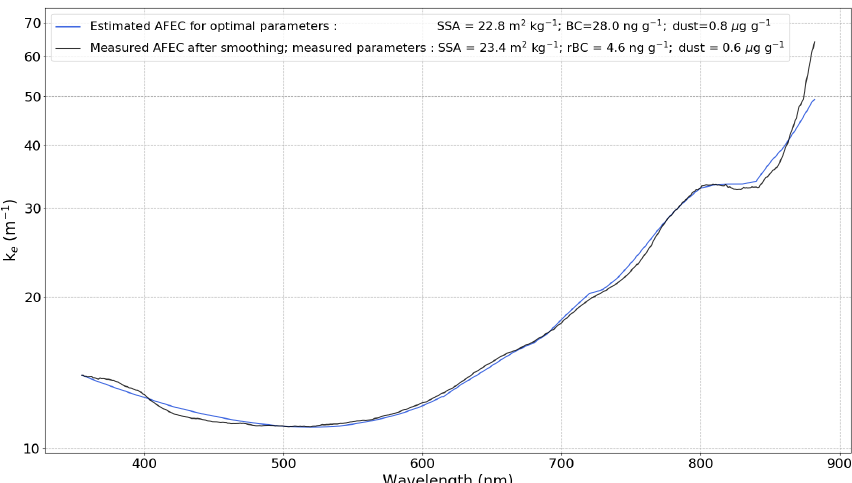
Figure 5. AFEC as a function of wavelength for the ZOIs between 11 and 14cm on the SOLEXS profile 002 on 13 February 2018. Measured AFEC after convolution filtering (black curve) is compared to the estimated AFEC from Eq. (12) with optimal parameters (blue curve). Note that rBC is the measured refractory BC concentration by the SP 2 instrument.